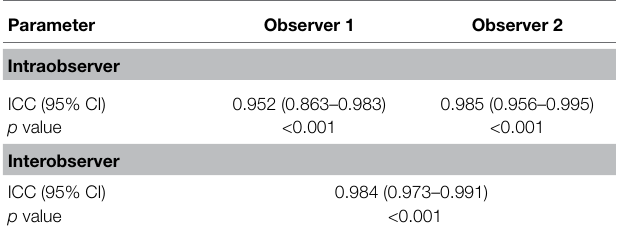
TABLE 1 | Basic characteristics of the study population. Characteristics